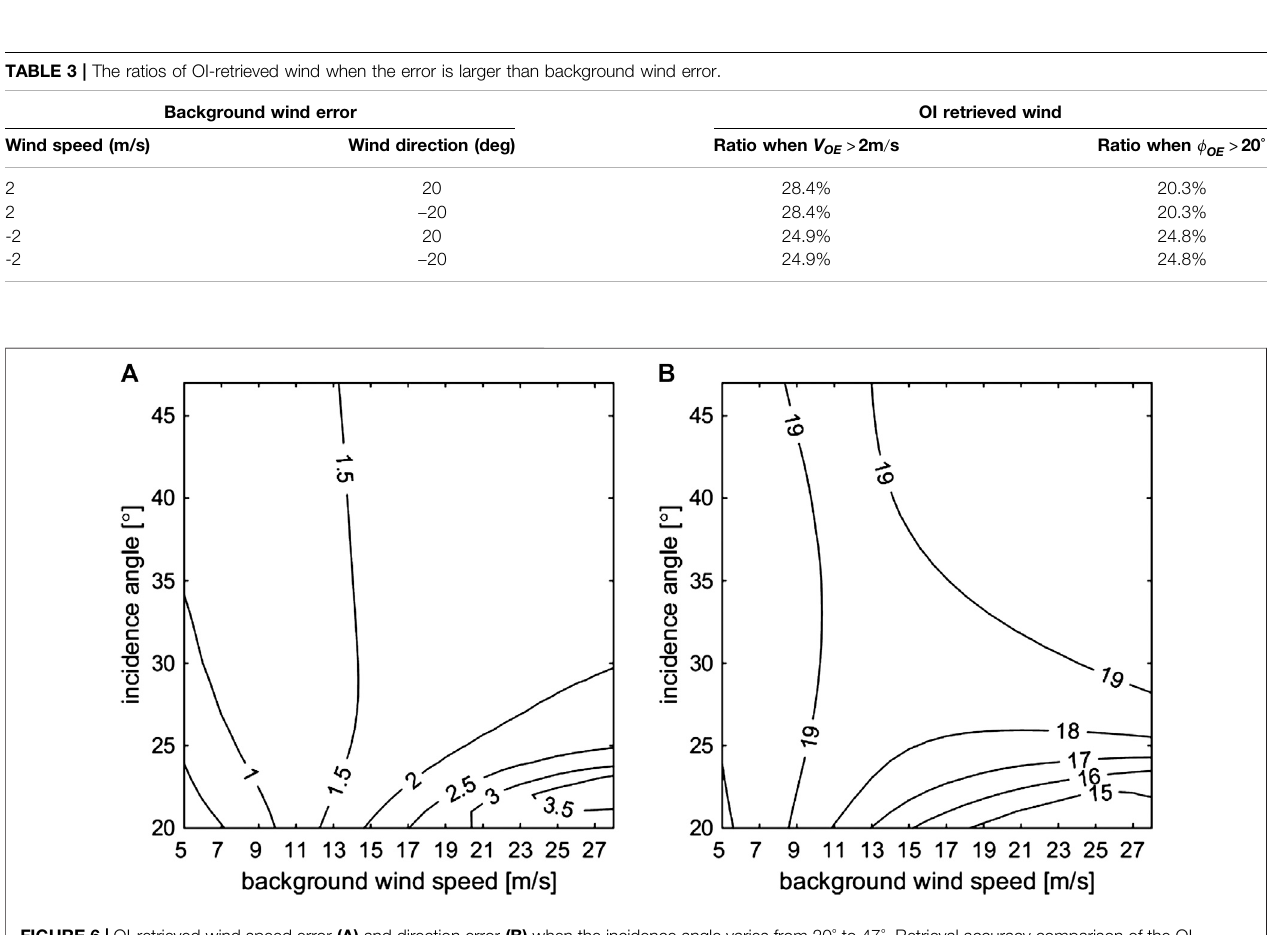
Frontiers in Earth Science |